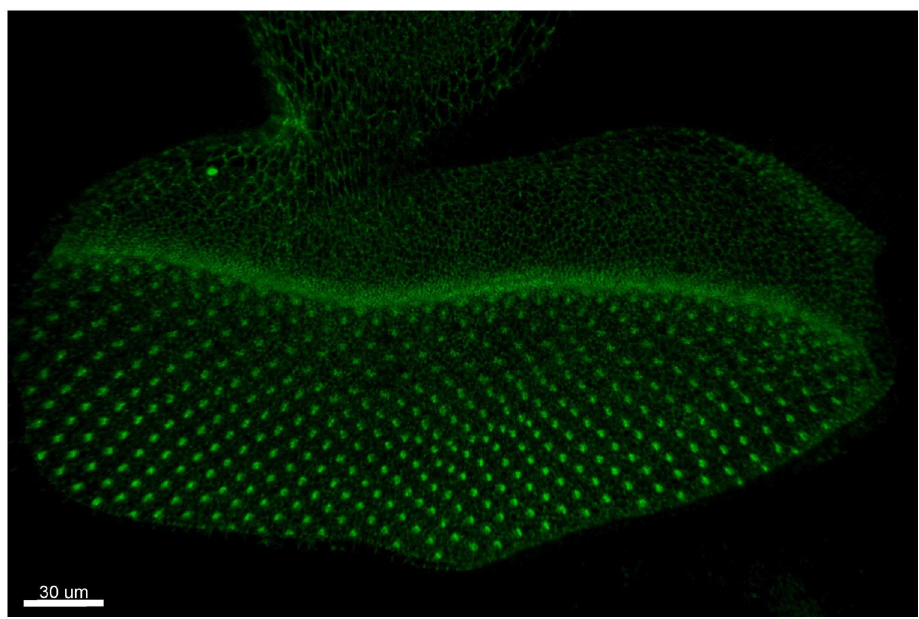
Fig 1. Experimental image of the positions of the R8 cells during morphogenesis. In this fluorescent microscopy image, one can see DE-Cadherin linked with GFP. This labels the top part of each cell shown as a ring. When multiple cells are in close proximity, they appear as one bright point, which in this case point the positions of the R8 cells.